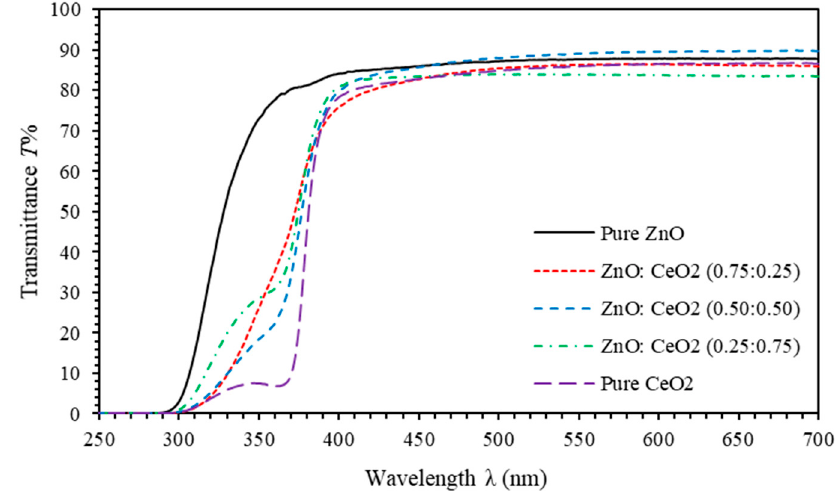
Figure 5. Transmittance T % ( λ ) spectra of pure ZnO, pure CeO 2 and ZnO:CeO 2 mixed oxides thin films.